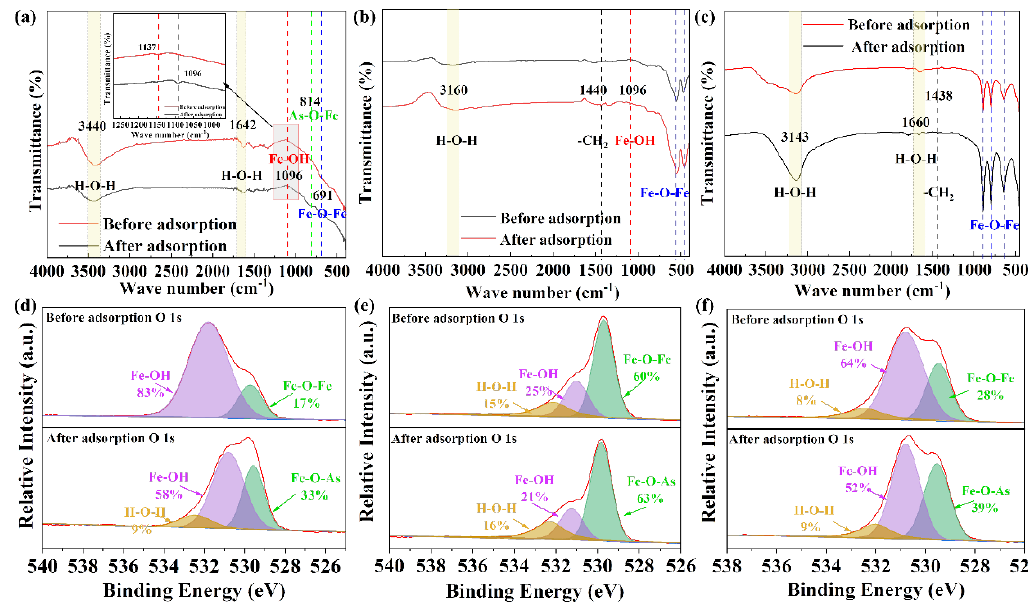
Figure 5. FTIR spectra of ( a ) ferrihydrite, ( b ) hematite, and ( c ) goethite. O 1s XPS spectra of ( d ) ferrihydrite, ( e ) hematite, and ( f ) goethite.